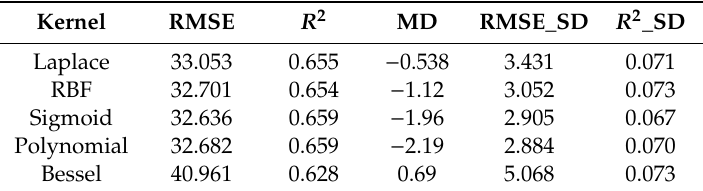
Table 9. Performances achieved by modeling with 83 features.